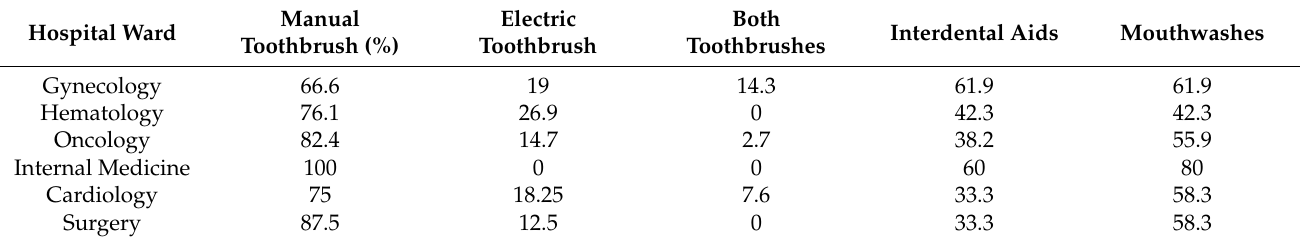
Table 3. Use of dental aids for oral hygiene by patients in each hospital ward